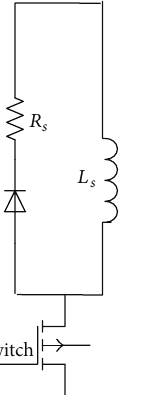
Figure 23: The current waveform of a switch (with LCL filter, capacitor bank, and RLD snubber).